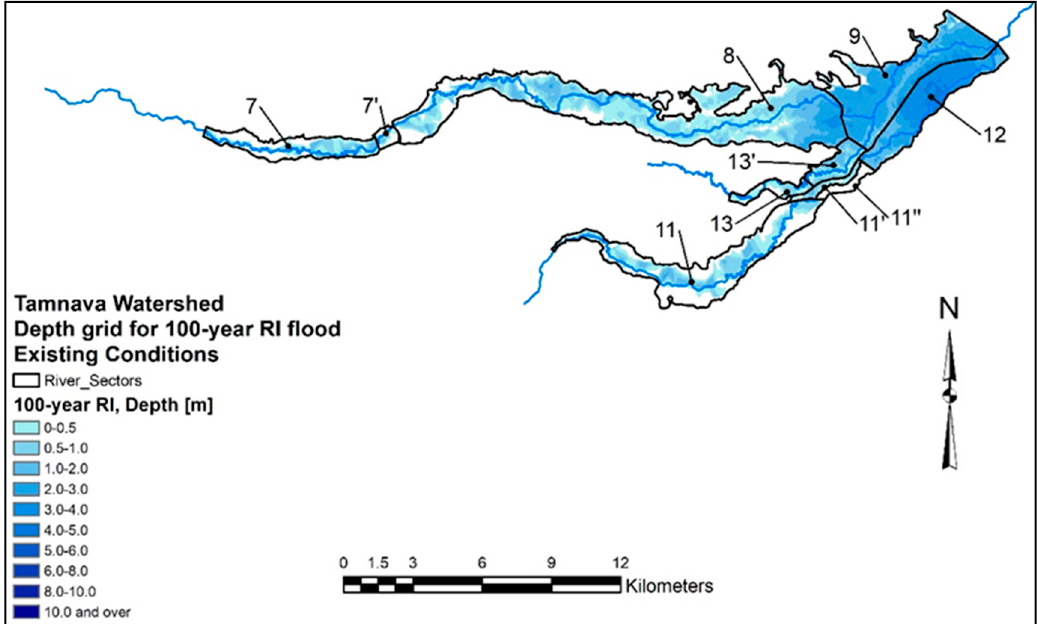
Figure 6. Flood hazard due to 100-year flood in the Tamnava watershed under the baseline scenario (existing flood protection system).